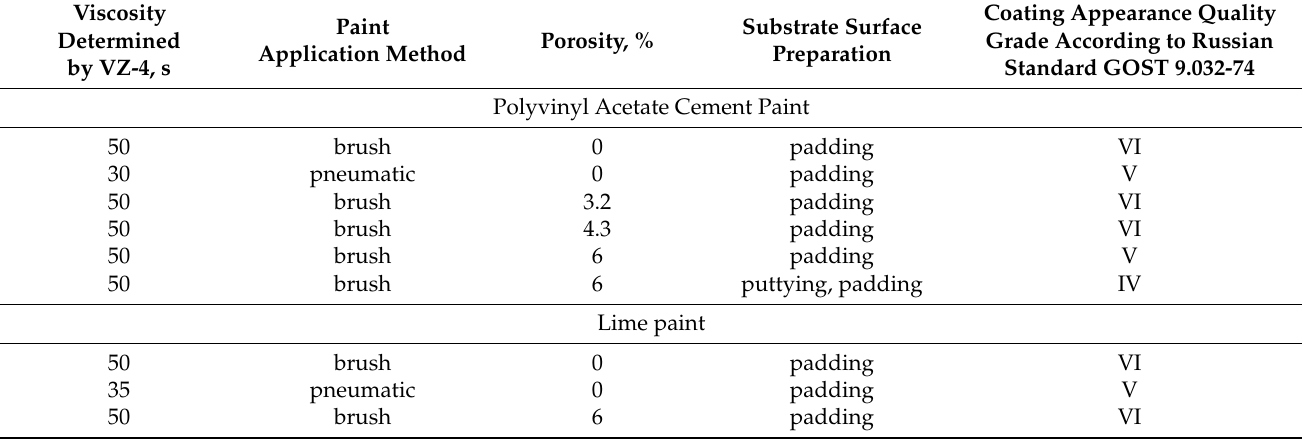
Table 6. Influence of the substrate surface preparation method on quality appearance of